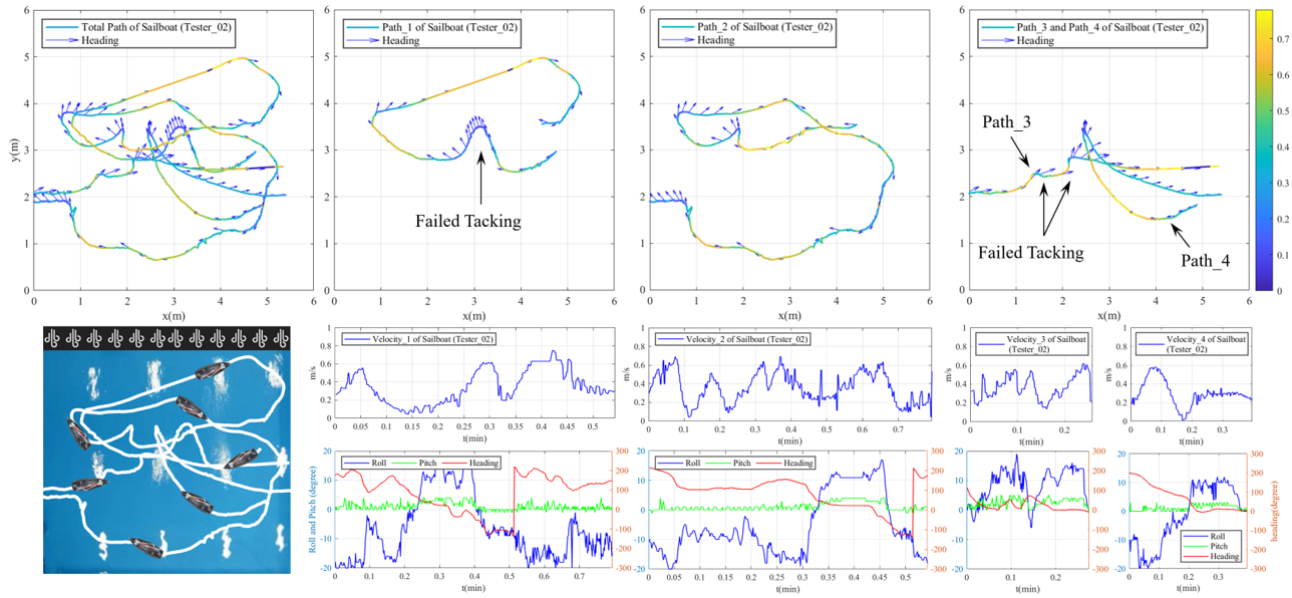
Figure 10. Remote sailing test (tester 02) in STAr. The content contained in the figure and its ordering correspond to that of tester 01.